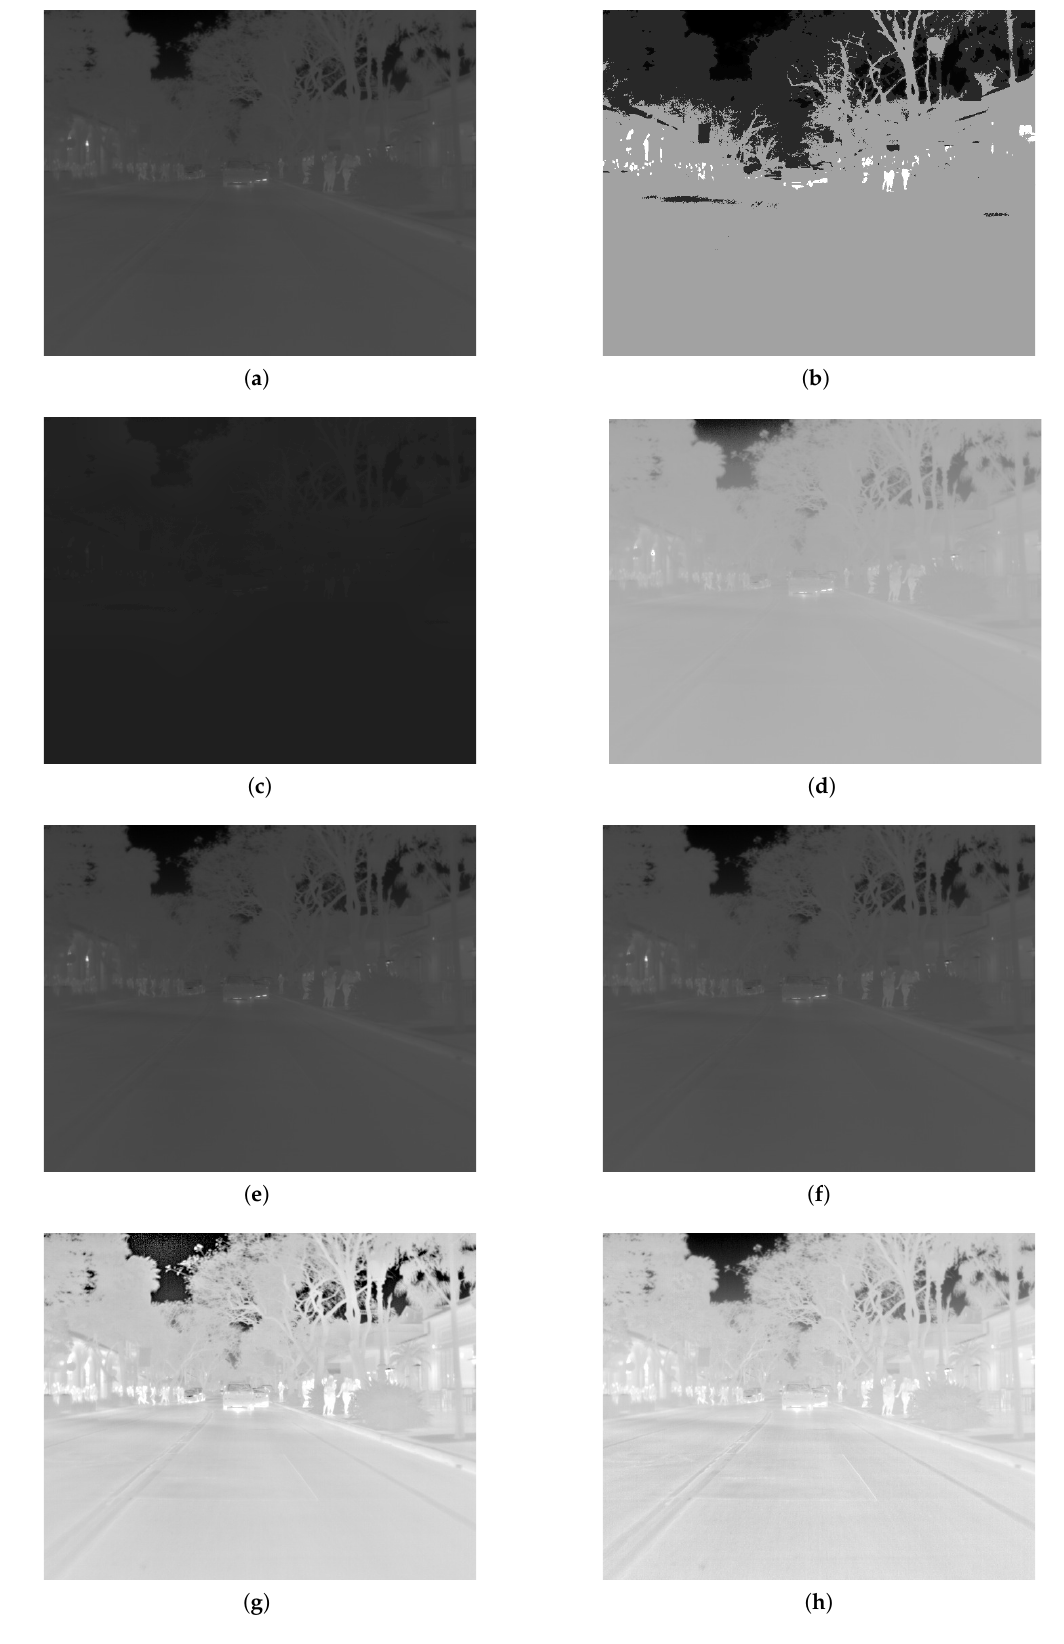
Figure 10. Comparison Results 7 (Image with Blurred Details). ( a ) Linear Mapping. ( b ) HE. ( c ) CLAHE. ( d ) AHPBC. ( e ) MSR. ( f ) Reinhard. ( g ) LEP. ( h ) Proposed